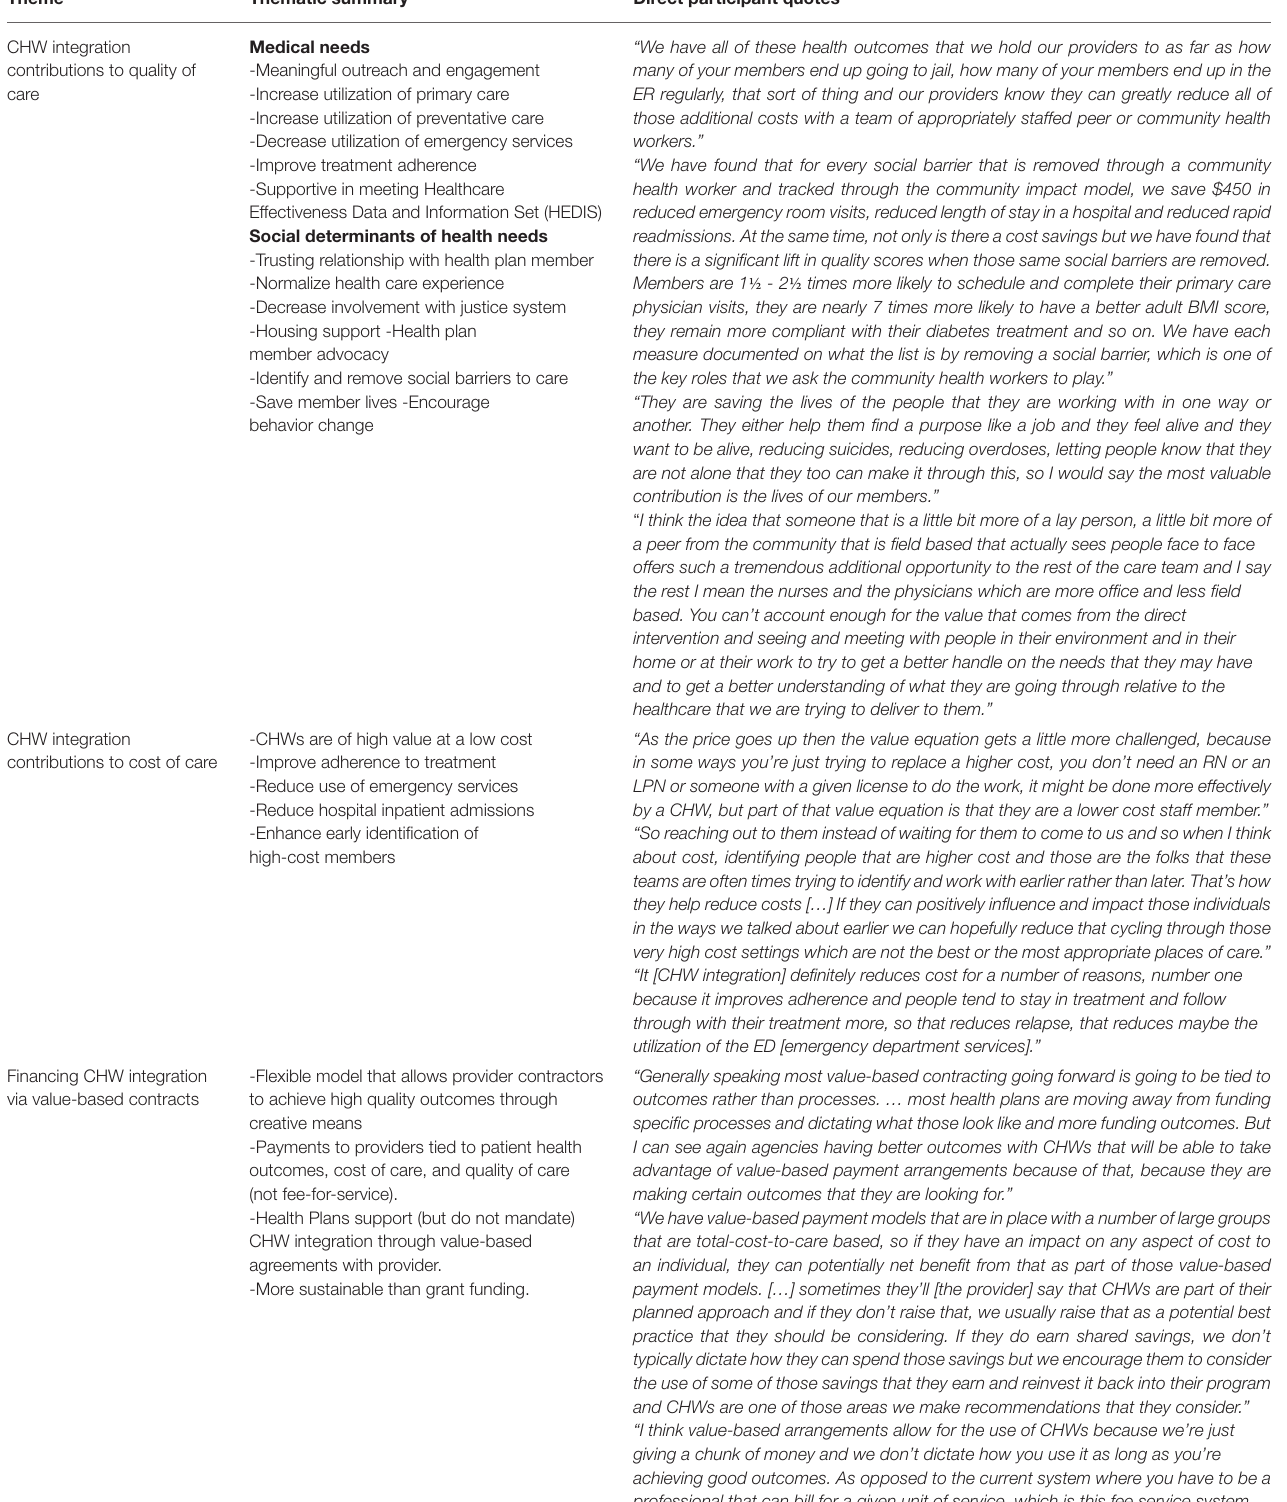
TABLE 4 | Health plan leaders attitudes, beliefs, and values regarding CHW health care systems change and integration. Theme Thematic summary Direct participant quotes CHW integration contributions to quality